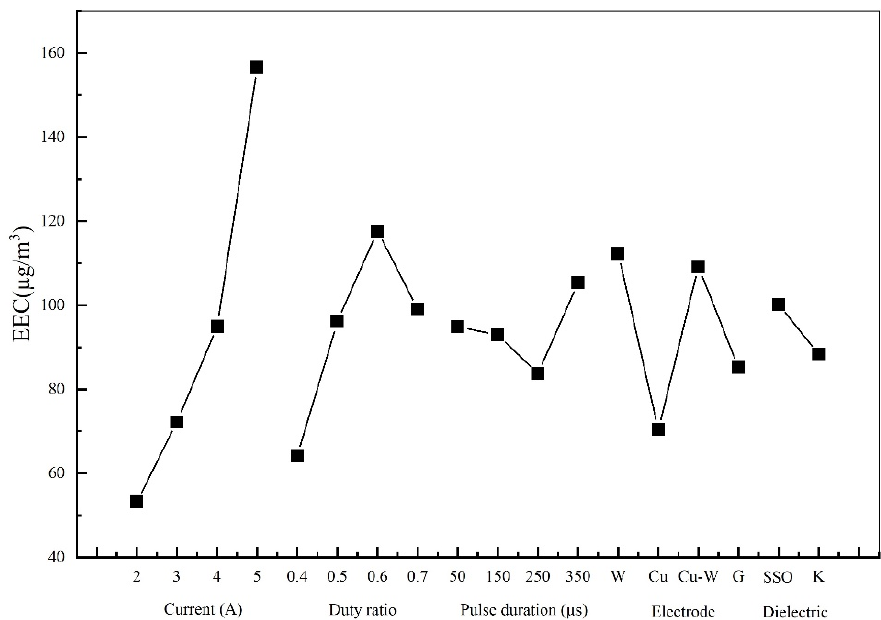
Figure 6. The influence of current, duty ratio, pulse duration, electrode and dielectric on EEC.